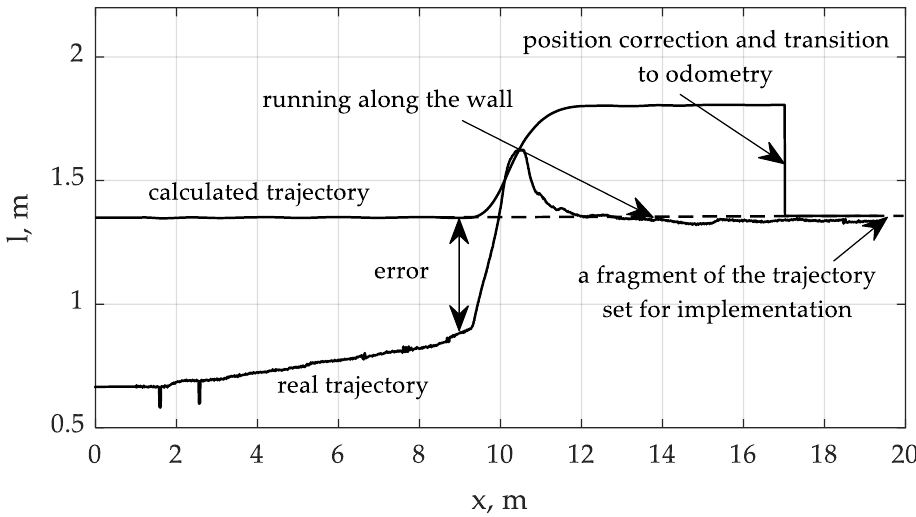
Figure 7. The courses of the real and theoretical trajectories with a non-parallel position.